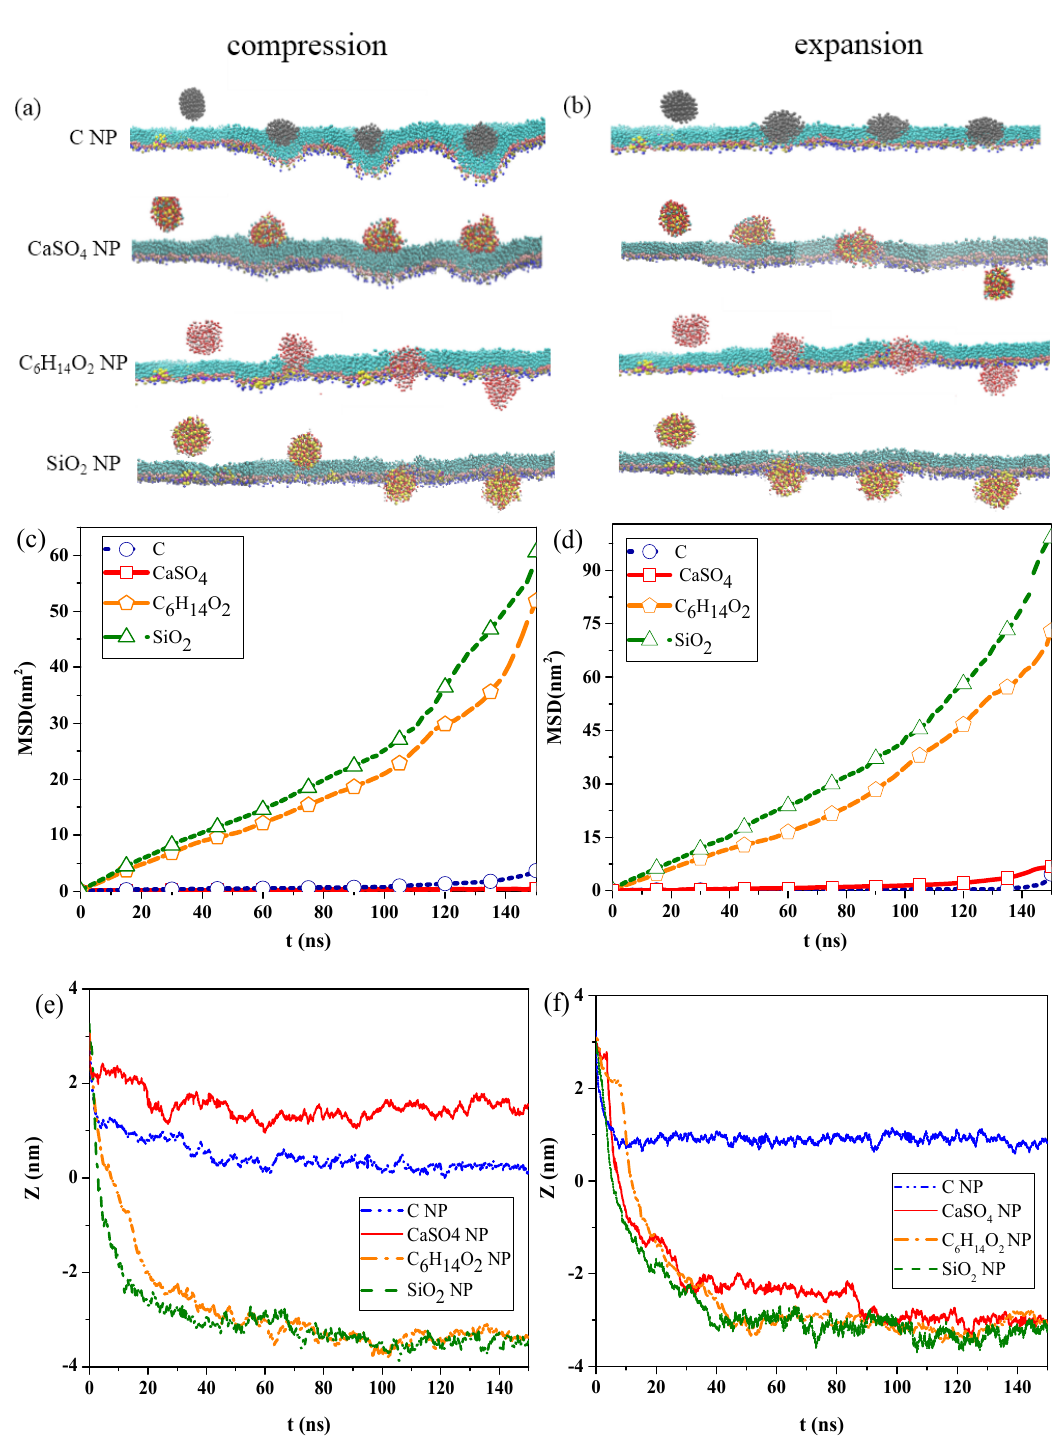
Figure 1. Interaction between nanoparticles (NPs) and the pulmonary surfactant monolayer. Snapshots of the interaction in the ( a ) exhalation and ( b ) inhalation breathing states; mean-square displacements (MSDs) of the NPs in ( c ) exhalation and ( d ) inhalation breathing states; centroid-to-centroid distance between the NPs and monolayer in ( e ) exhalation and ( f ) inhalation breathing states.